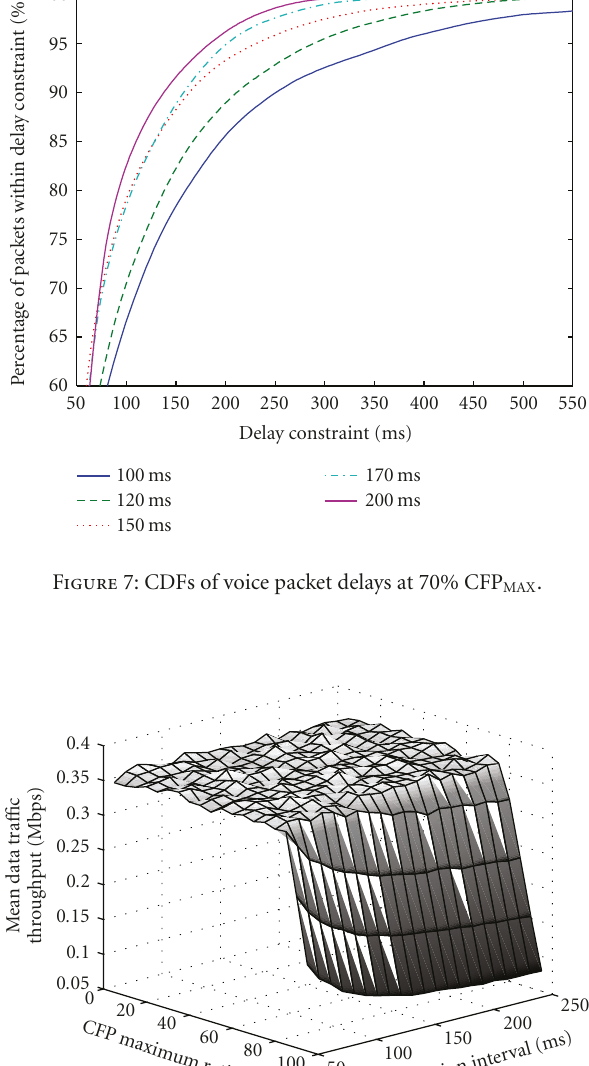
Table 3: Model parameter definitions and values.